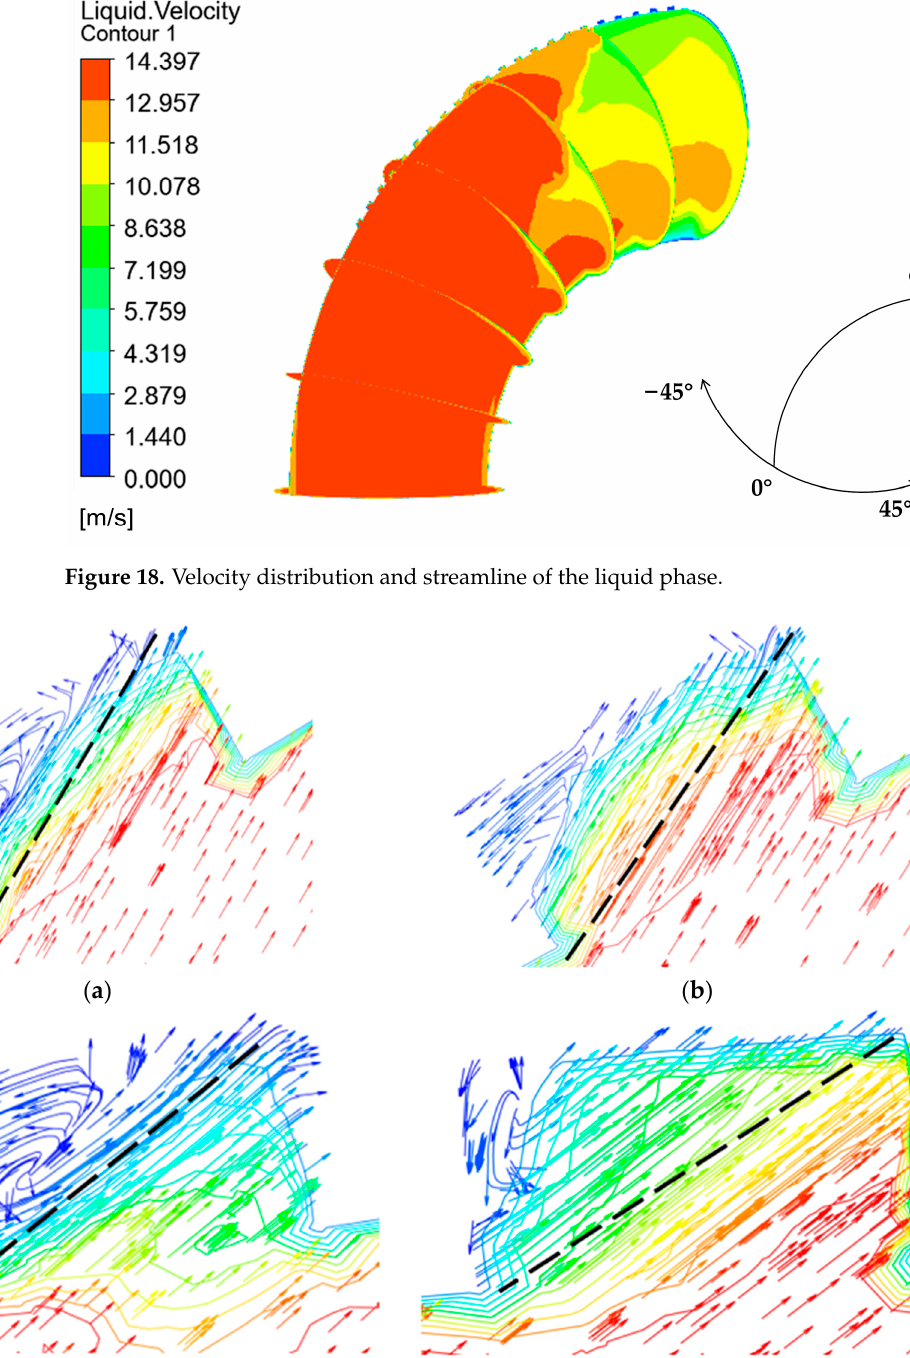
Figure 19. Velocity distribution and streamline of the liquid phase in the holes: ( a ) location 1; ( b ) location 2; ( c ) location 3; ( d ) location 4.